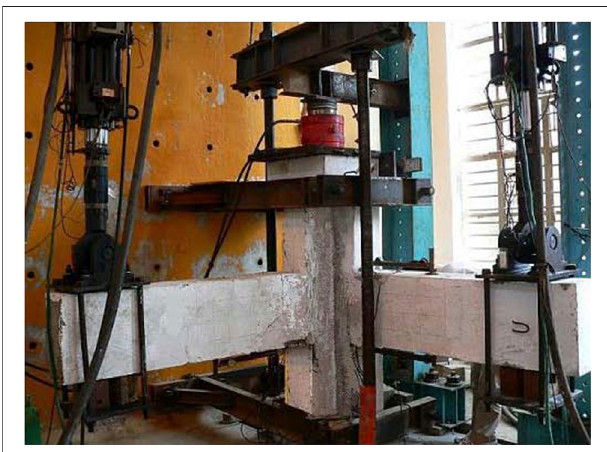
FIGURE 10 | Picture of loading devices (Xiang et al., 2017).